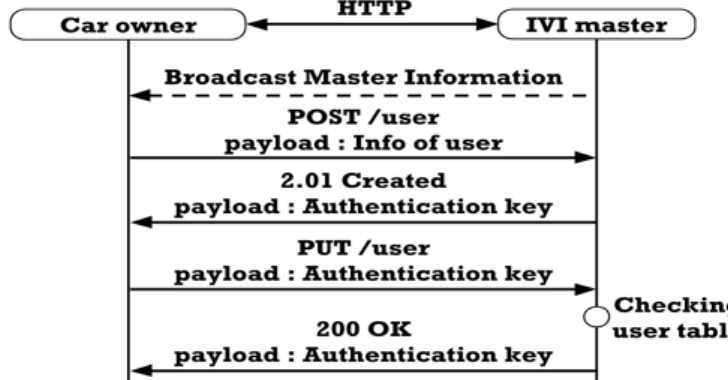
Figure 8. Operation flows for Car Owner registration .